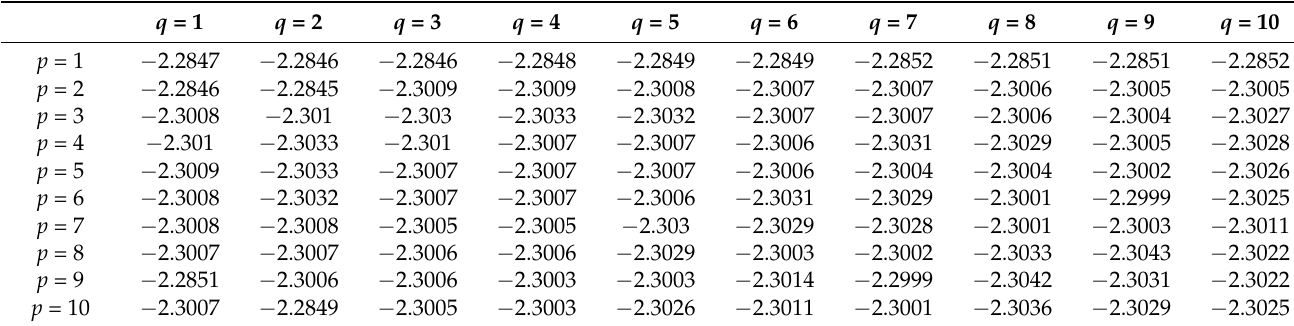
Table 3. AIC values corresponding to different p and q .